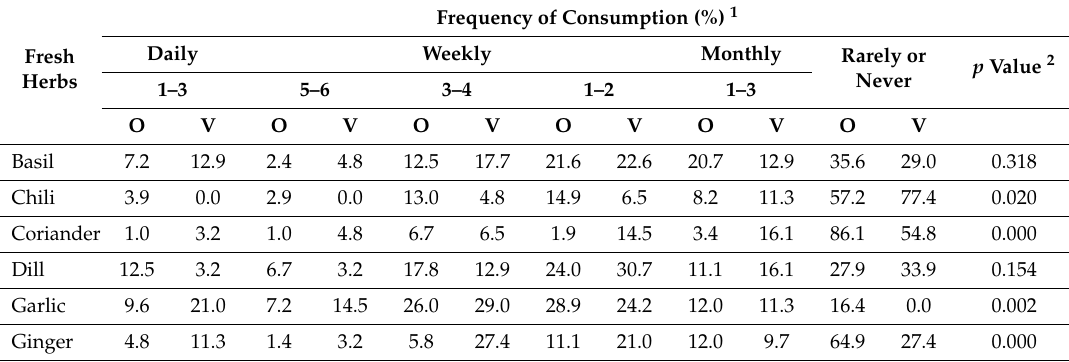
Table 2. Frequency of consumption of fresh herbs among adult omnivores and